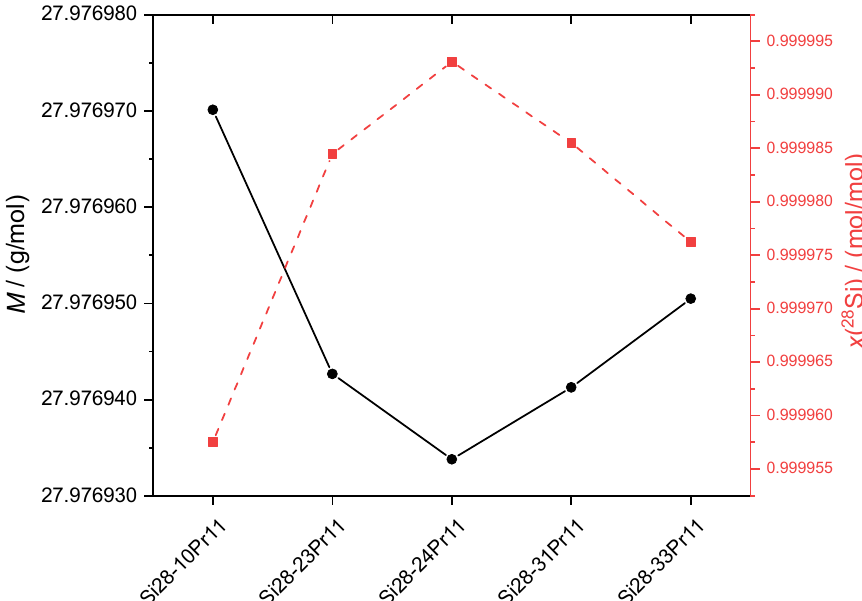
Figure 6. Left scale (filled circles): Average molar masses M of the available silicon crystals highly enriched in 28 Si. Right scale (filled squares): Amount-of-substance fractions x ( 28 Si) displaying the “enrichment” of the respective crystal. Uncertainties for both M and x ( 28 Si) are not displayed, because of their extremely small values being hidden by the data points. Data for the crystal Si28-31Pr11 are yet preliminary due to the limited number of samples.